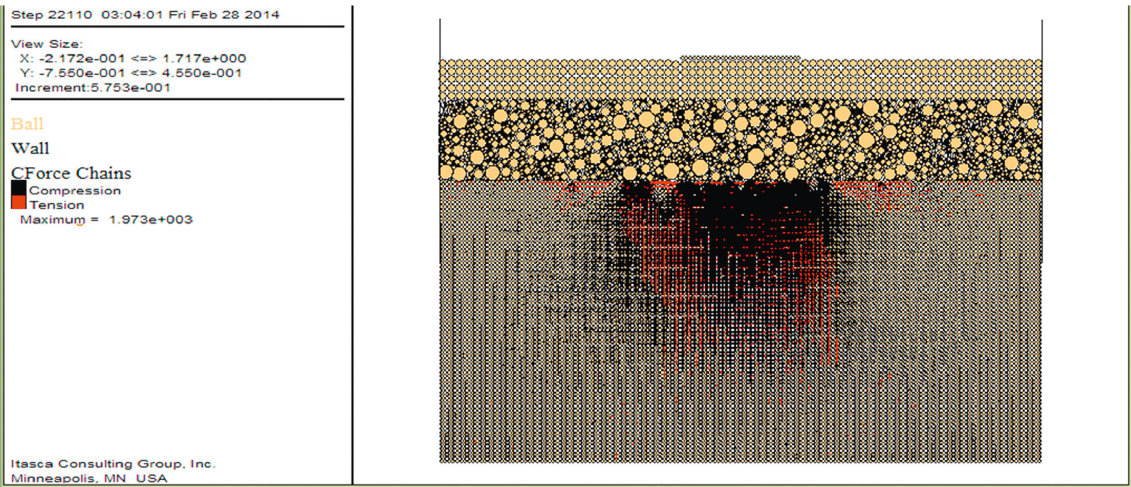
Figure 6: Stress distribution of subgrade soil layer (black and red denote pressure and tension,